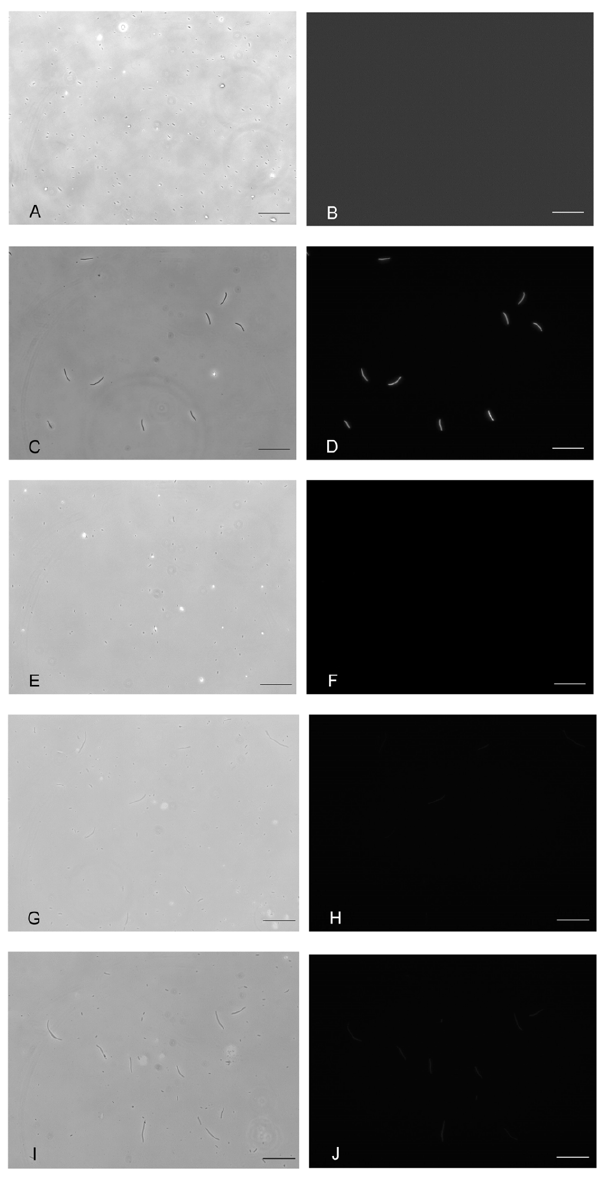
Figure 4. ‘‘Memory effect’’ upon short-term IPTG exposure. Visible light and UV-light images of PB103: p TAK117-minC exposed to 10 mM IPTG for 15 min (E, F),30 min (G, H) and 60 min (I, J) before washing and resuspending the cells in IPTG-less LB amp50 medium. Controls include cells not exposed to IPTG (A, B) and cells grown under continuous exposure to 2 mM IPTG (C, D). Images were taken after 2 h 30 min of exposure to 10 mM IPTG. Scale bar is 50 m m.